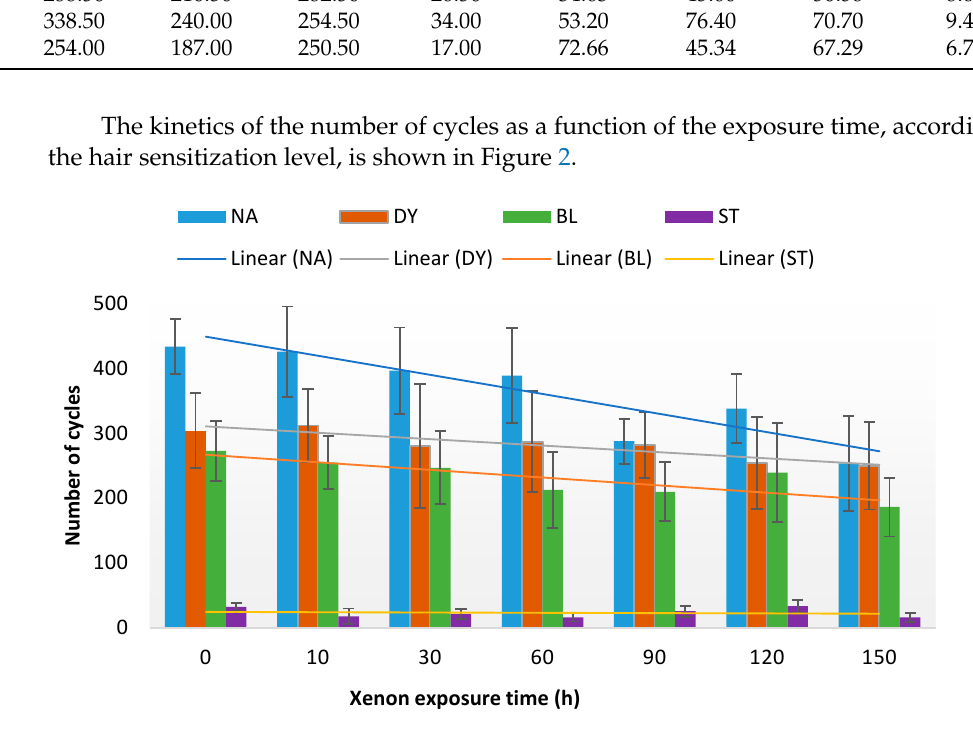
Figure 2. The number of flexabrasion cycles before the hair breakage occurs as a result of exposure time to the Xenon arc lamp for each group of sample sensitization levels (NA, BL, DY, and ST).